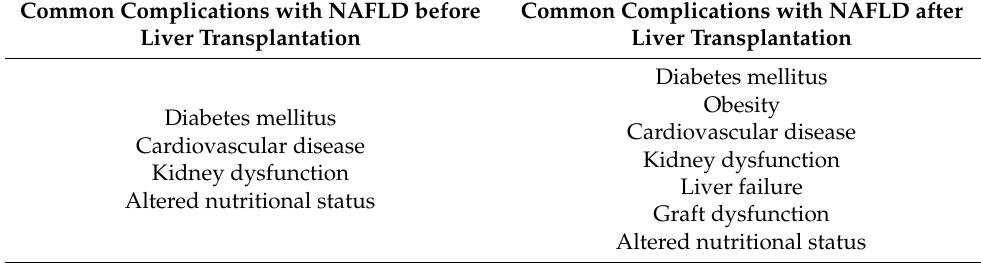
Table 1. Pre- and post-LT complications